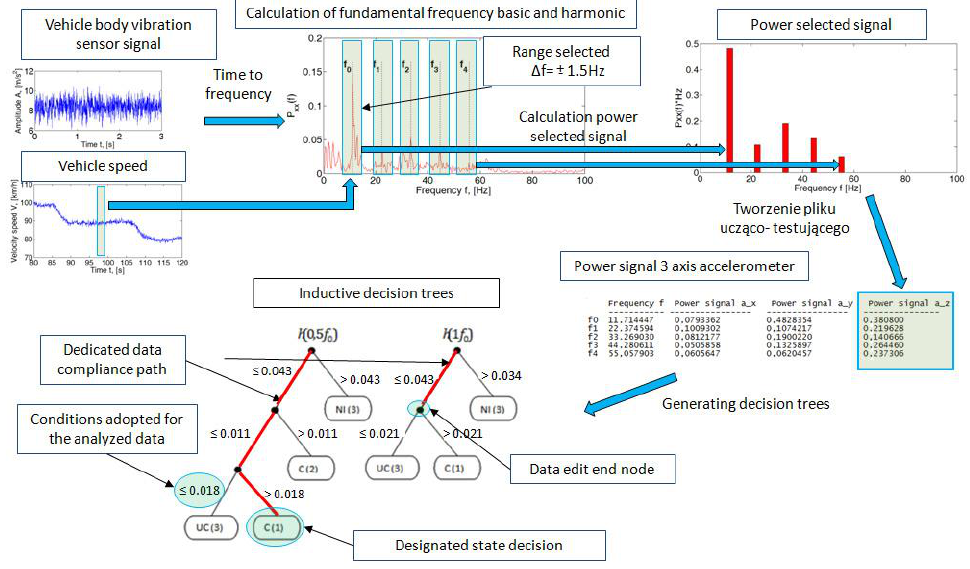
Figure 3. Data analysis structure.